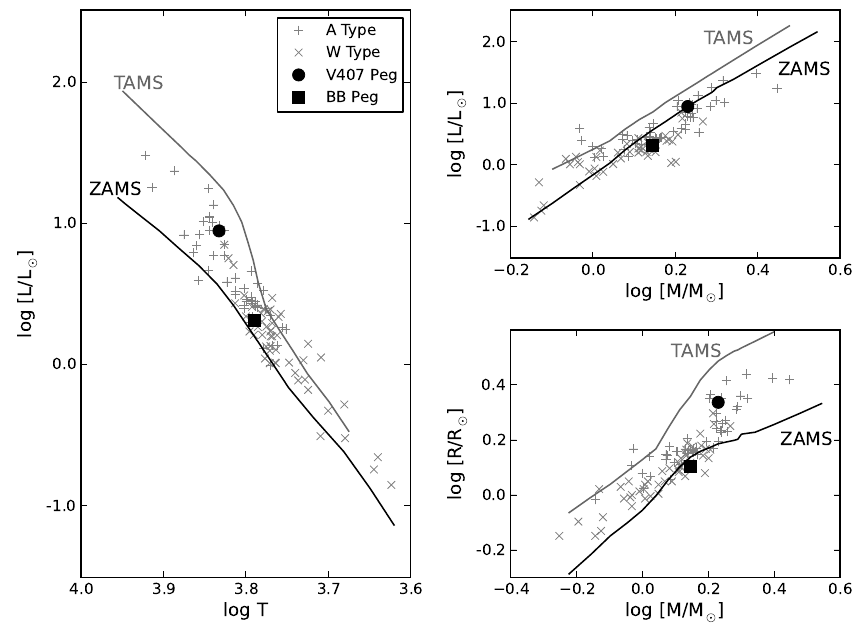
Fig. 6. HRD (left), mass-luminosity (top right), and mass-radius (bottom right) di- agrams of the selected set of W UMa primaries, and the primary components of our targets. ZAMS and TAMS data are taken from the theoretical models of Girardi et al. (2000) for solar composition. The legends on the HRD apply to other two diagrams as